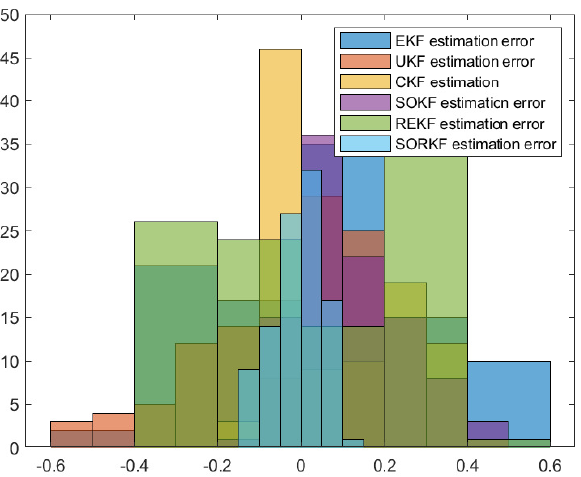
Figure 13. Histogram of R1 positioning estimation error in random topology formation.